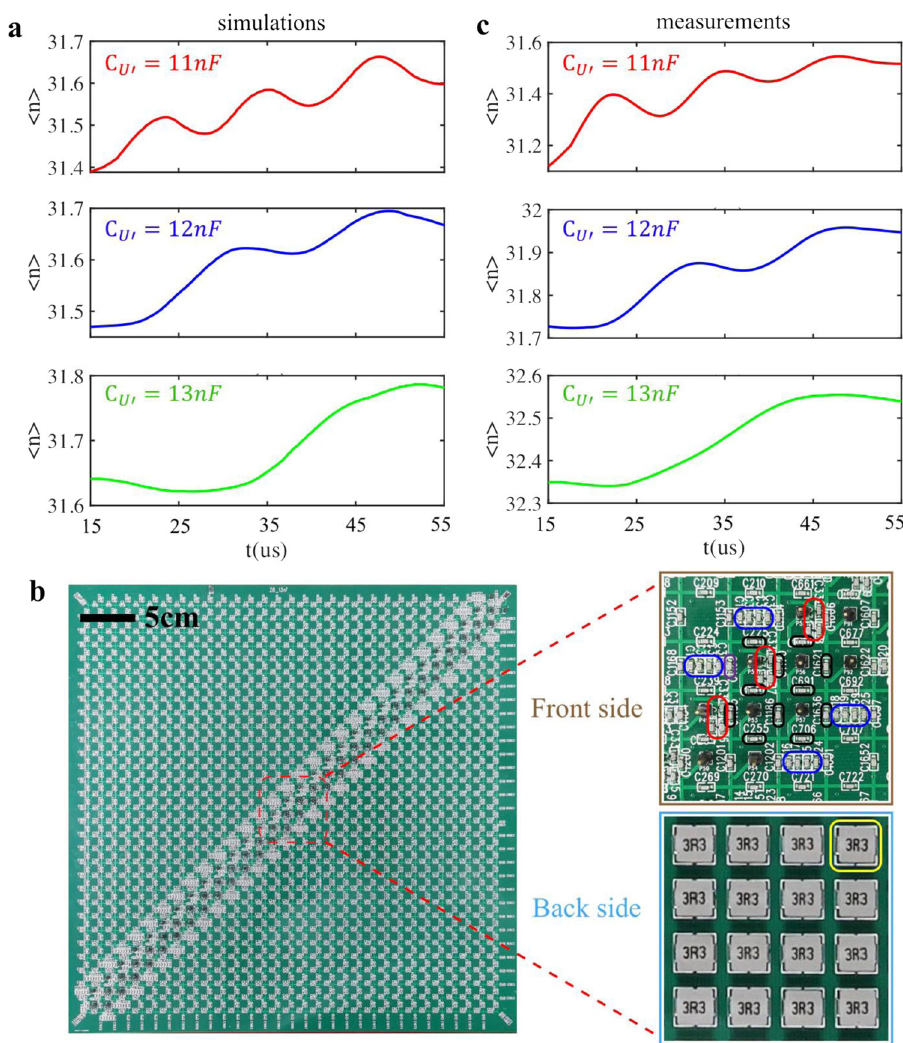
Fig. 2 The results for observing interaction-induced Zitterbewegung of doublons in electric circuits. a The red, blue, and green lines correspond to simulated results of the center mass ( 〈 n 〉 ) for the input voltage-packet as a function of time with C U 0 = 11, 12 and 13 nF, respectively. b The left chart plots the photograph image of the fabricated circuit, and the corresponding enlarged view is presented in right charts. The red, blue, and green circles enclose the grounding capacitor C U , C U 0 on the main and fi rst lateral diagonals and grounding inductor L g , respectively. The value of C, C U , and L g are taken as 1, 15 nF and 3.3 μ H, respectively. c The measured results of the center mass in the time domain are presented by red, blue and green lines with C U 0 = 11, 12 and 13 nF,